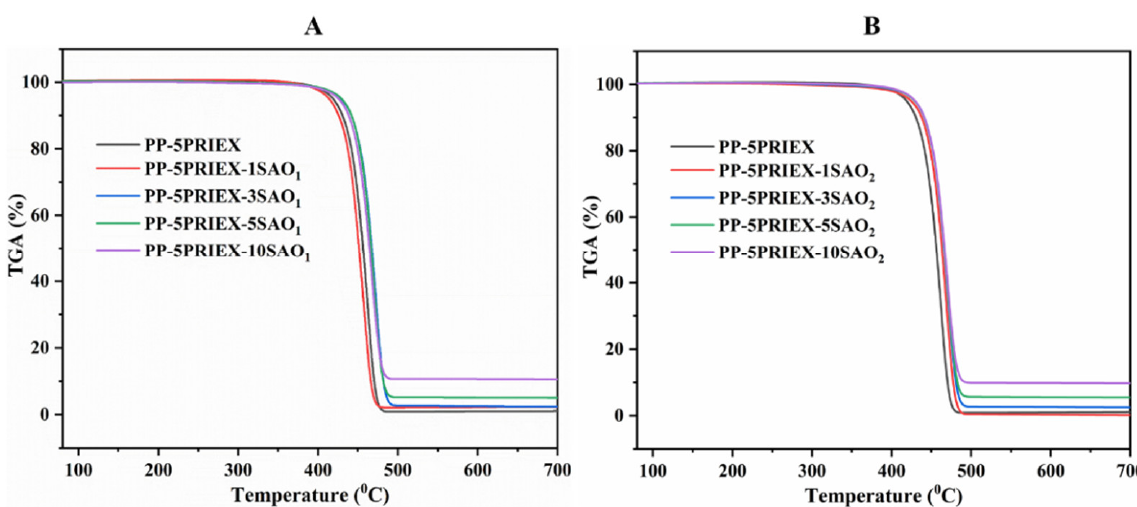
Figure 2. TGA results of PP/PRIEX / SAO 1 ( A ) and PP/PRIEX / SAO 2 ( B ) composites . 3.2. Tensile Strength, Tensile Modulus and Storage Modulus of PP/PRIEX/SAO 1 and